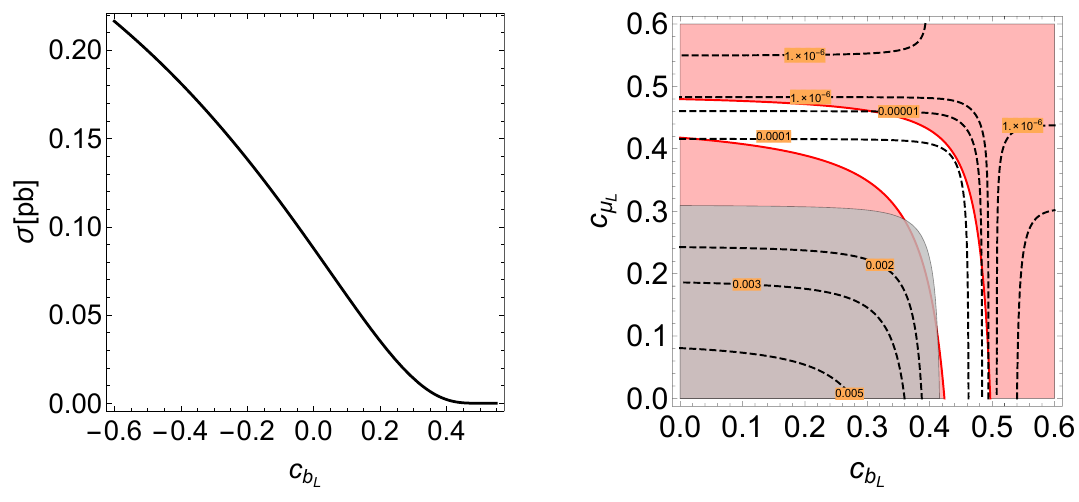
Figure 12 . Left panel: cross-section production (in pb) in our model for Z n ( n = 1) from bottom- bottom fusion in as a function of c b (in pb) in the plane ( c b experimentally excluded region (cid:27) the R K anomaly. We have considered c (cid:28)